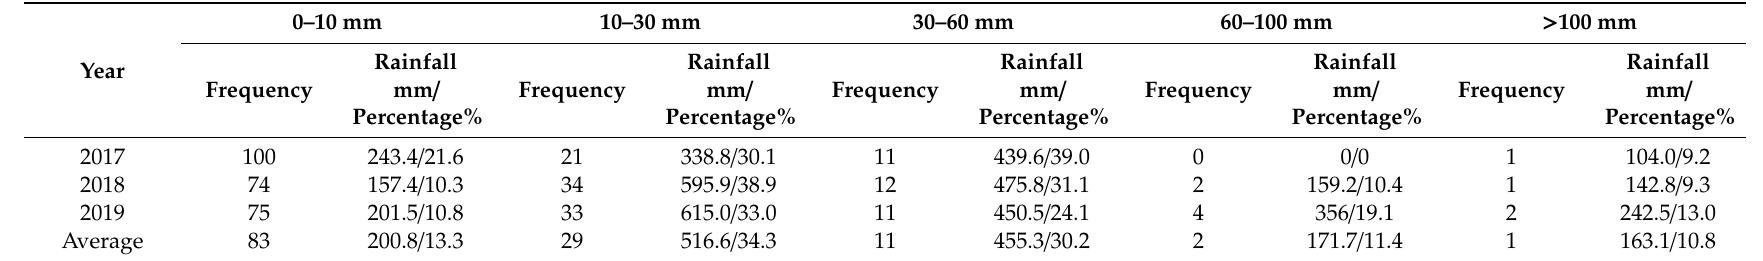
Table 2. Statistic of rainfall and rain frequency during the study